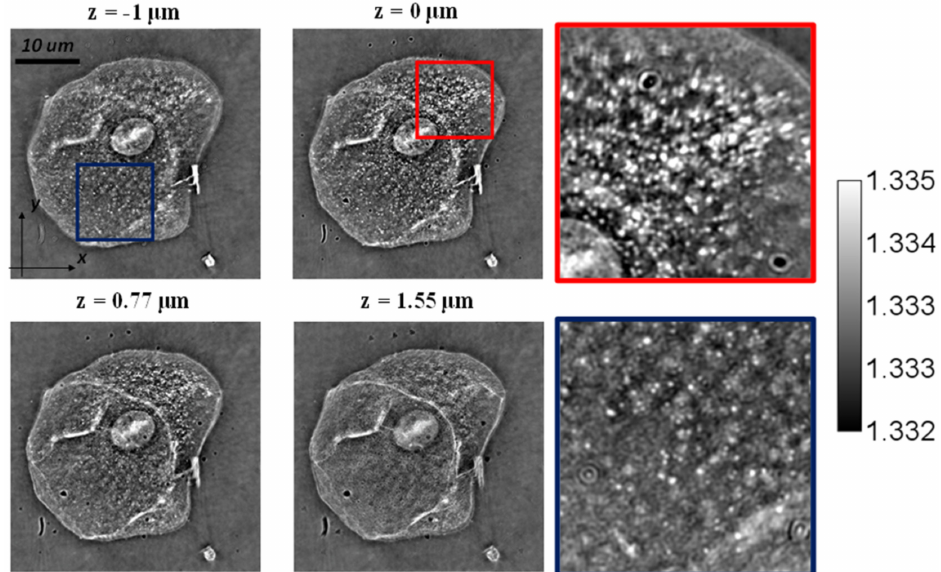
Figure 5. 3D RI reconstruction at different depths the left column is the highlighted regions at z = − 1 µ m (dark blue) and z = 0 um (red). The images show the high resolution due to the use of a partially incoherent LED source with the speckle noise highly